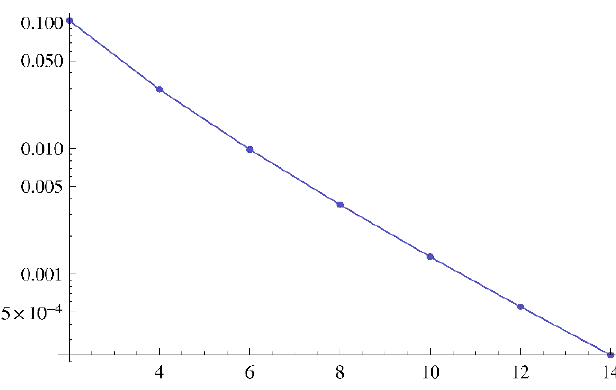
Figure 6. Second example: errors. x -axis: degree of interpolating polynomial. y -axis: relative L